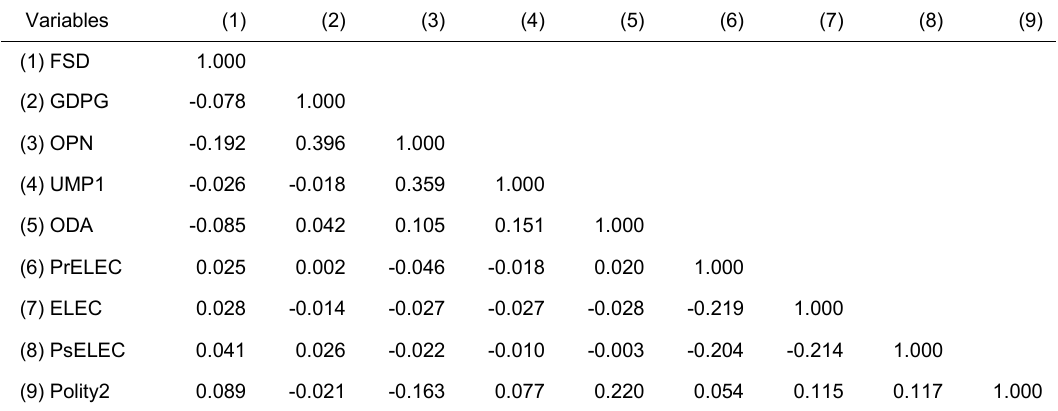
Table 2. Estimated correlation coefficients among